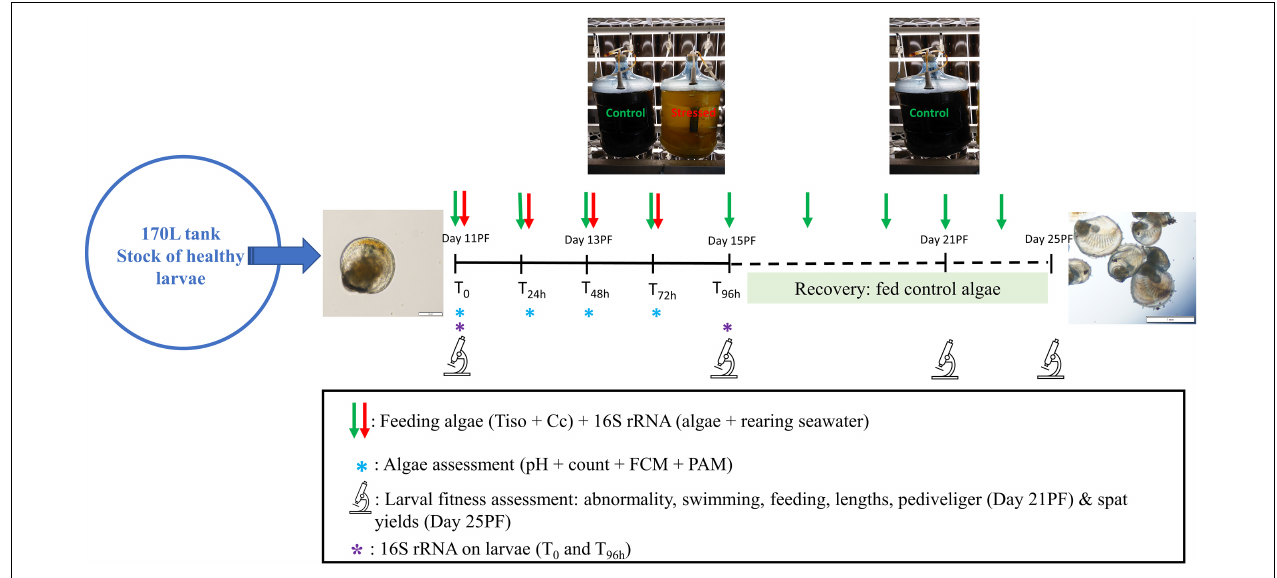
FIGURE 1 | Experimental design. Tiso, Tisochrysis lutea ; Cc, Chaetoceros calcitrans ; PF, post-fertilization; FCM, flow cytometry; PAM, pulse amplitude modulation; 16S rRNA, microbiome